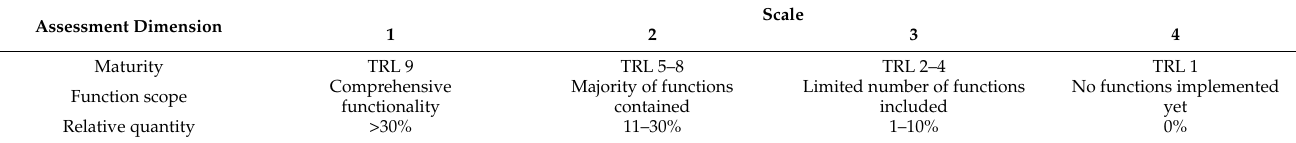
Table 3. Selected scale to evaluate maturity, function scope and relative quantity of DEMS.